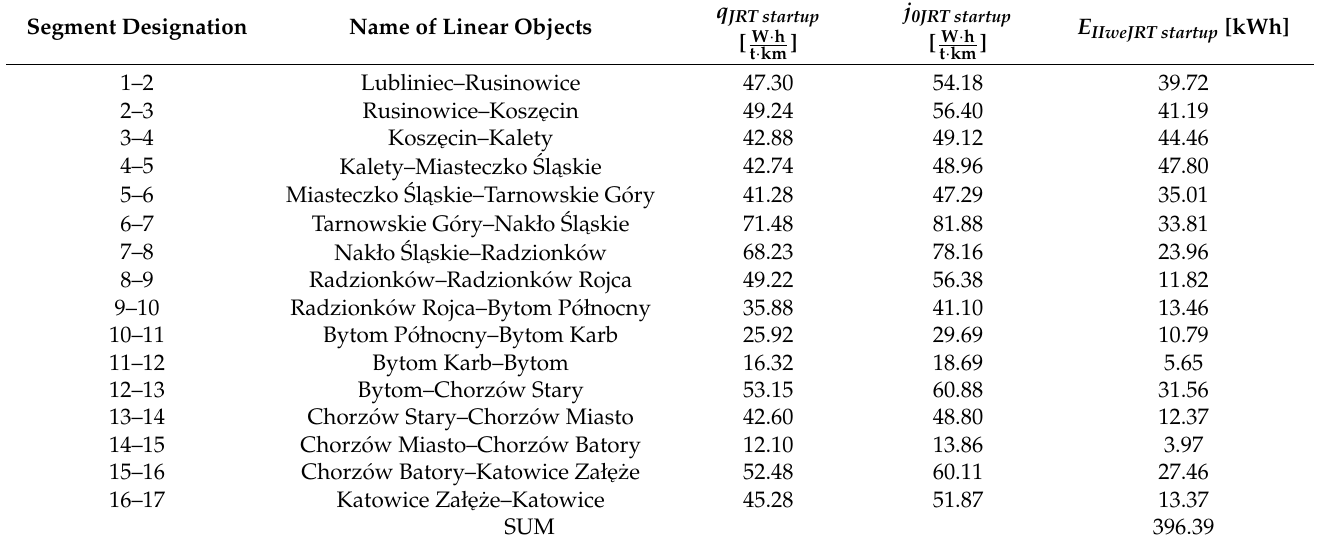
Table 5. Calculated electricity consumption values q JRT startup , j 0JRT startup and E IIweJRT startup (Variant II, the new approach during startup on jointed railway